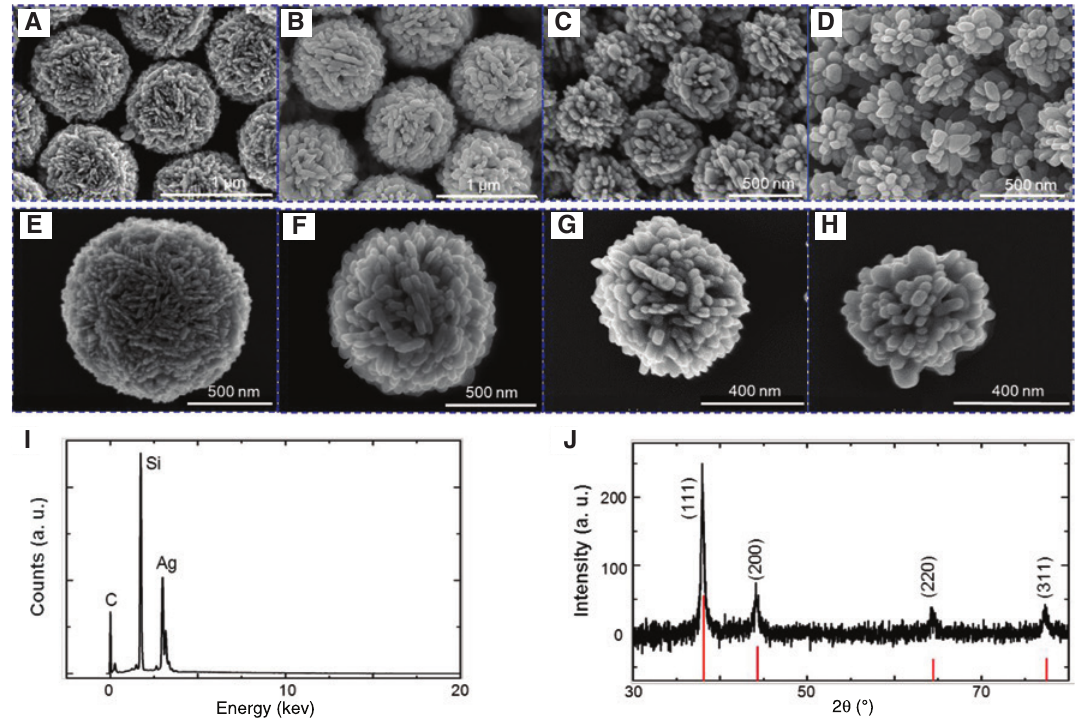
Figure 1: Characterization of the fabricated Ag